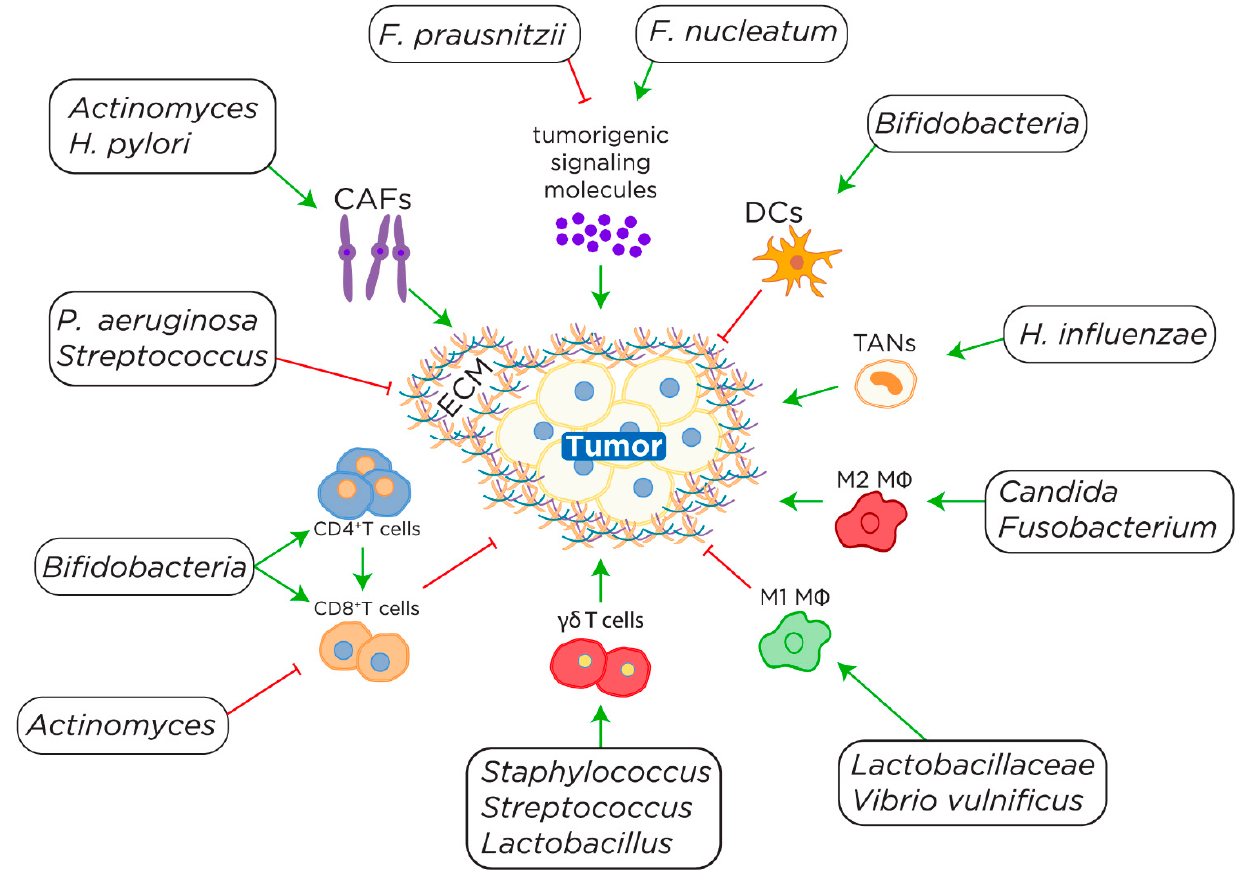
Figure 1. The regulatory effects of specific microbiota on the TIME. Microbiota have a variety of inducing (green arrows) and inhibitory (red arrows) effects on immune cells. These effects are mediated through the modulation of immune and supportive cells within the TIME and translate into tumor-suppressive (red arrows) and tumor-promoting (green arrows) effects. Dendritic cells (DCs), M1 macrophages (M Φ ), and CD8 + T cells generally have an antitumor response within the TIME. On the other hand, cancer-associated fibroblasts (CAFs), M2 M Φ s, tumor associated neutrophils (TANs), and γδ T cells promote tumorigenesis. It is possible that the same microbiota may have different effects on the TIME depending on the context.